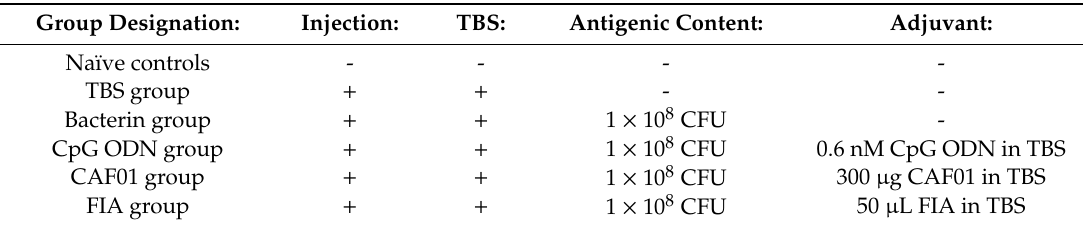
Table 1. Designation and content of experimental